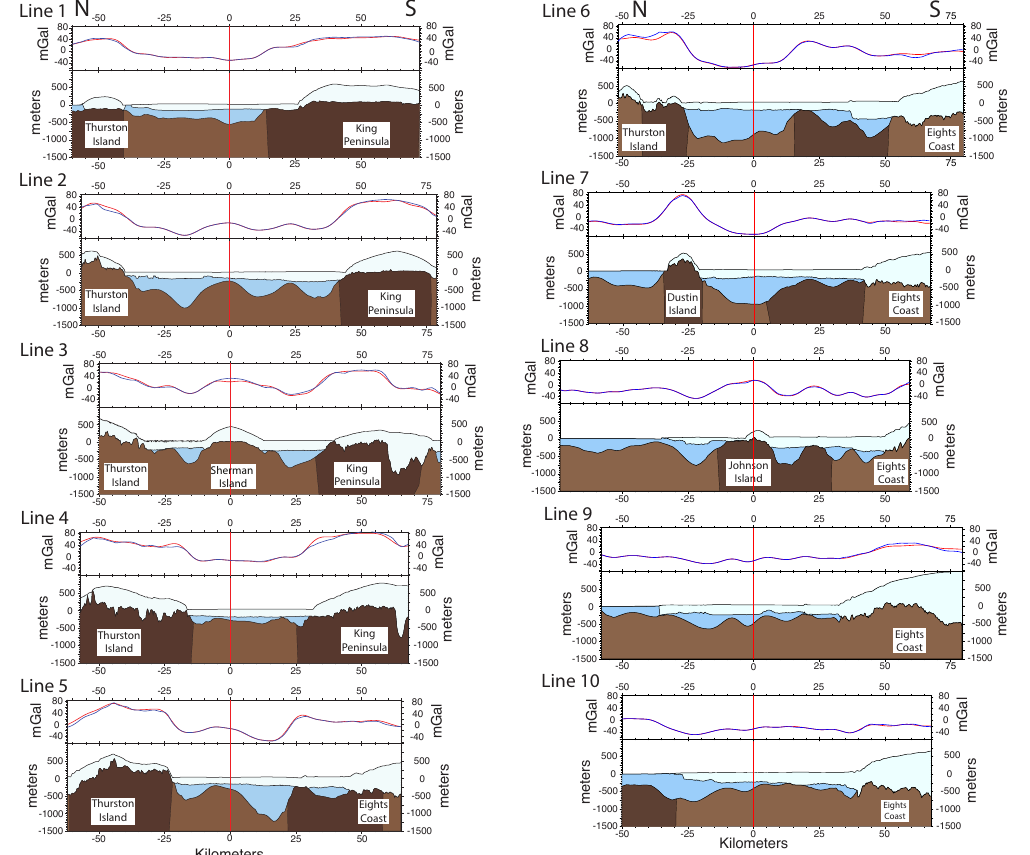
Fig. 3b. As in Fig. 3a, but for the north–south airborne geophysics lines, with vertical red lines indicating intersections with along-axis line 0 (Fig.